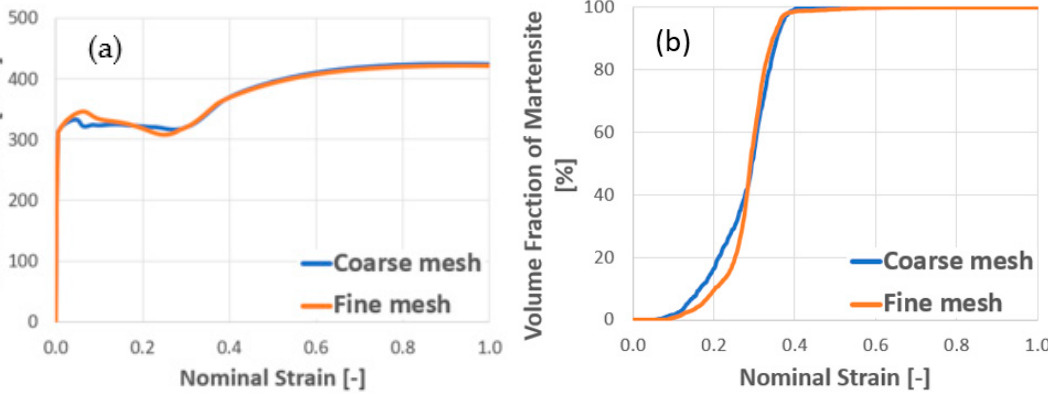
Figure 20. The dependence of mesh refinement as size of embryo ( a ) nominal stress versus nominal strain and ( b ) the volume fraction of martensite versus nominal strain.